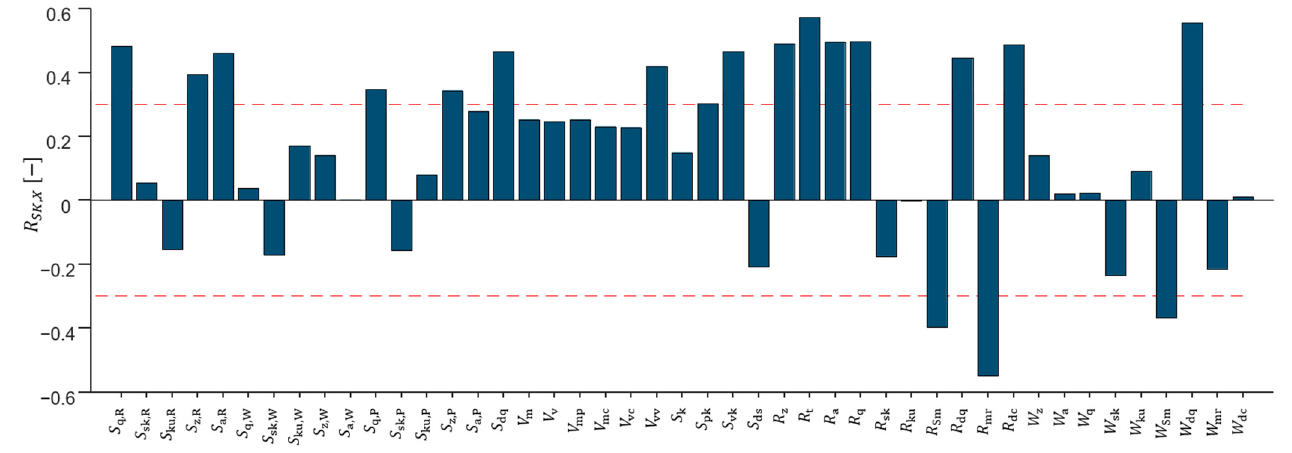
Figure 8. Rank correlation coefficients of the investigated surface properties with the assessed damage grade DG . All properties outside the marked boundary satisfy the requirement of significant correlation.